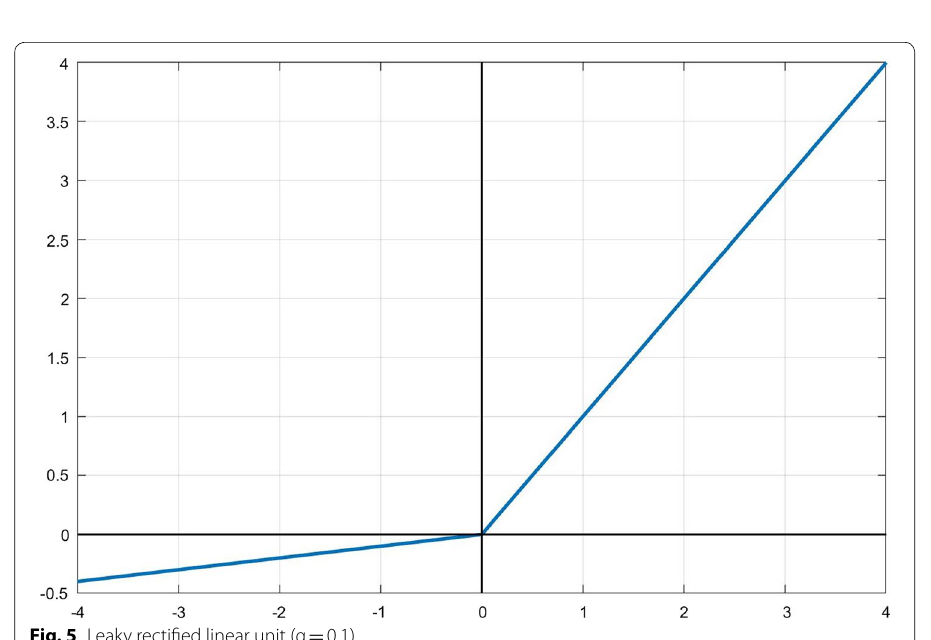
Fig. 5 Leaky rectified linear unit (α